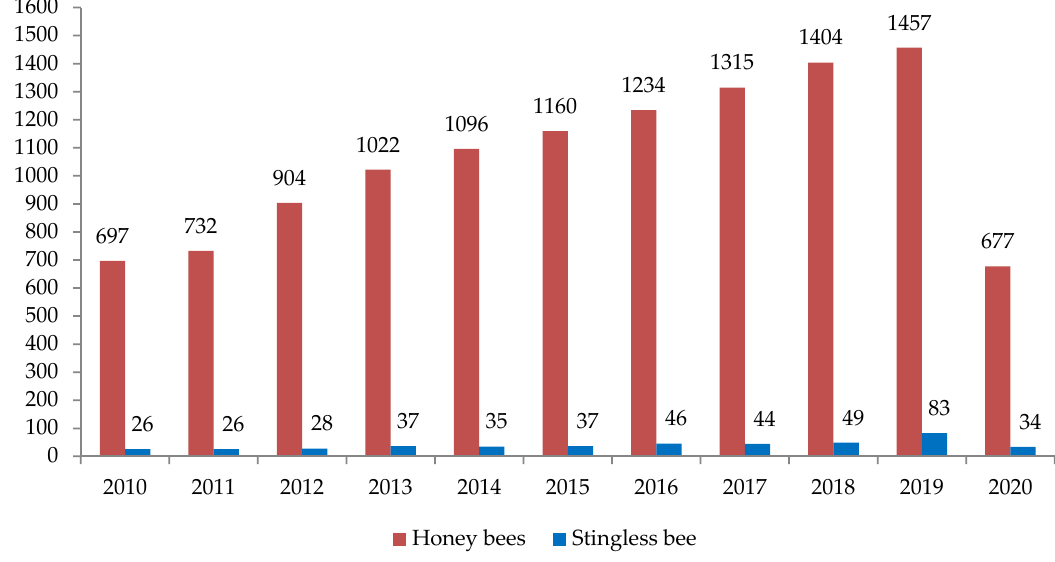
Figure 3. A comparison between the annual publications on both stingless bees and honey bees in the recent 10 years. Applied on PubMed database on May 9, 2020, by using search terms: (Honeybee; Honey bee; Apis; European bee; Western bee) and (Stingless bee; Melipona; Trigona).